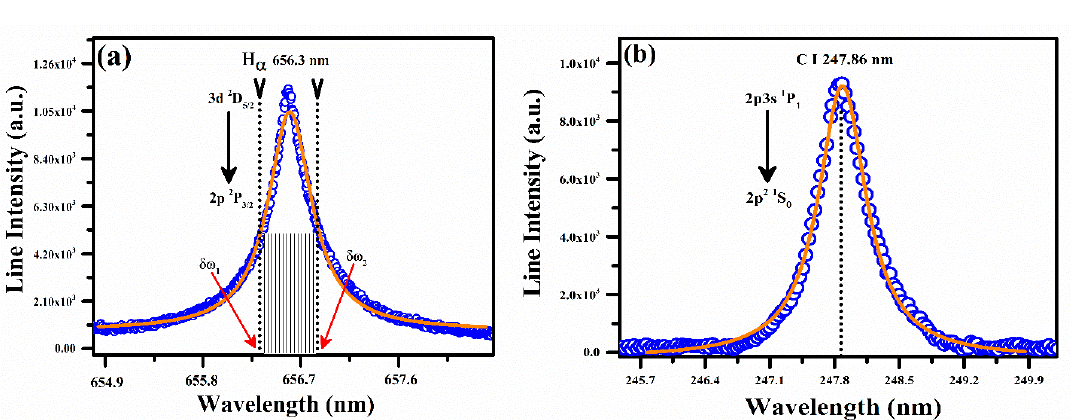
Figure 4. ( a ) H α spectral line; ( b ) Stark-broadened-line-profile of C-I spectral line emits at wavelength 247.86 nm. 247.86